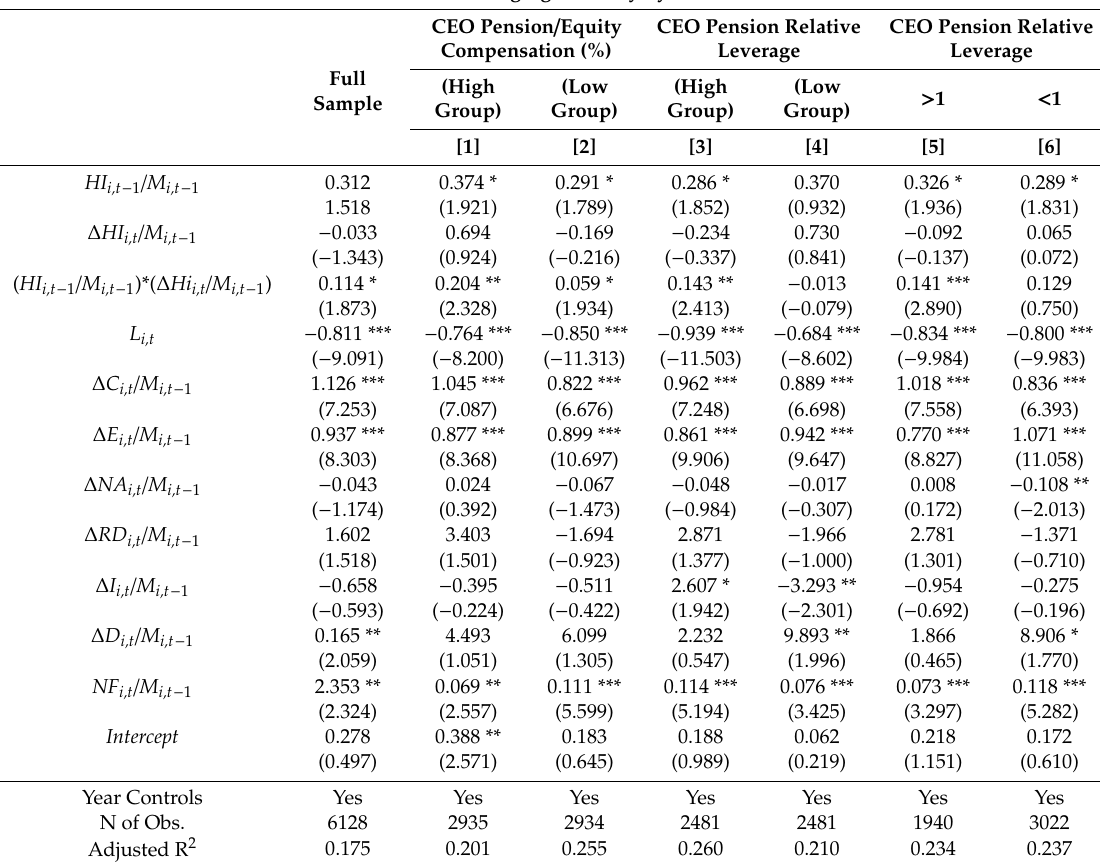
Panel B: The Value of Hedging Intensity by Pension